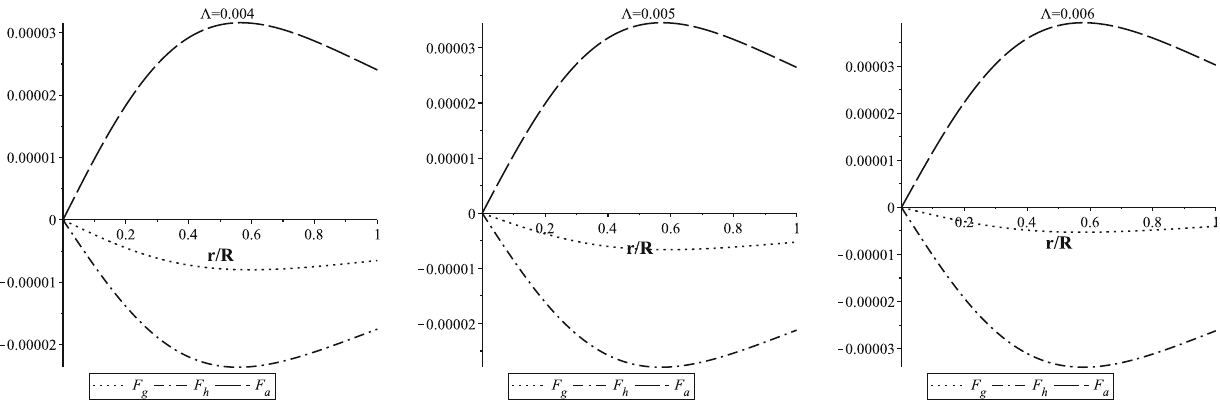
Fig. 6 Behavior of the energy conditions for Λ = 0 . 004 (left panel), Λ = 0 . 005 (middle panel) and Λ = 0 . 006 (right panel) as a function of the fractional radial distance for the strange star candidate LMC X − 4 are shown